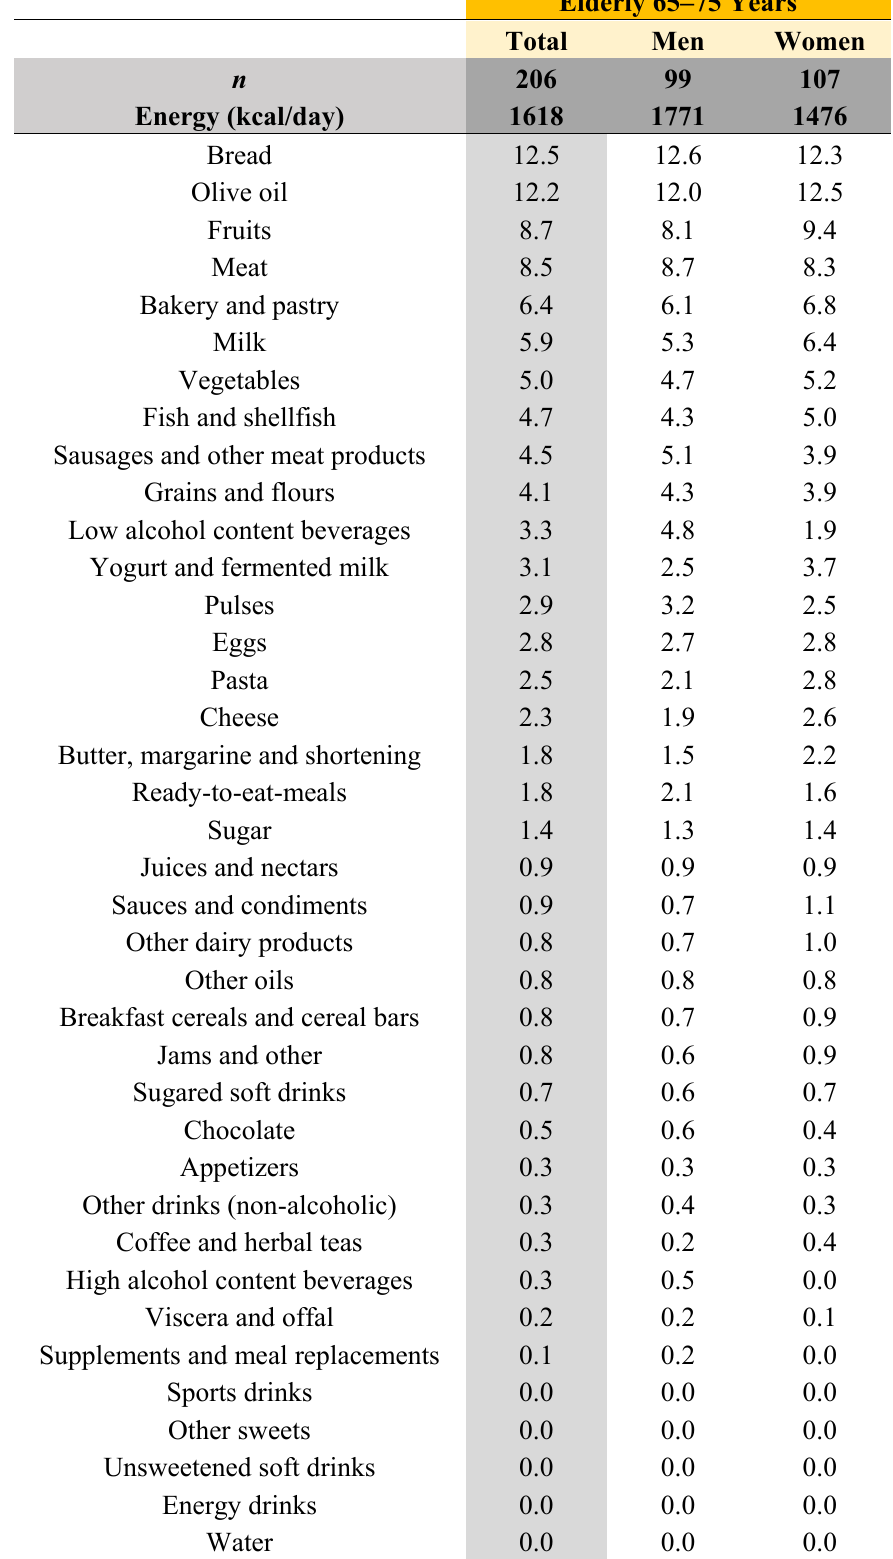
Table 9. Dietary sources of energy (%) from food subgroups in elderly adults from the ANIBES survey of the Spanish